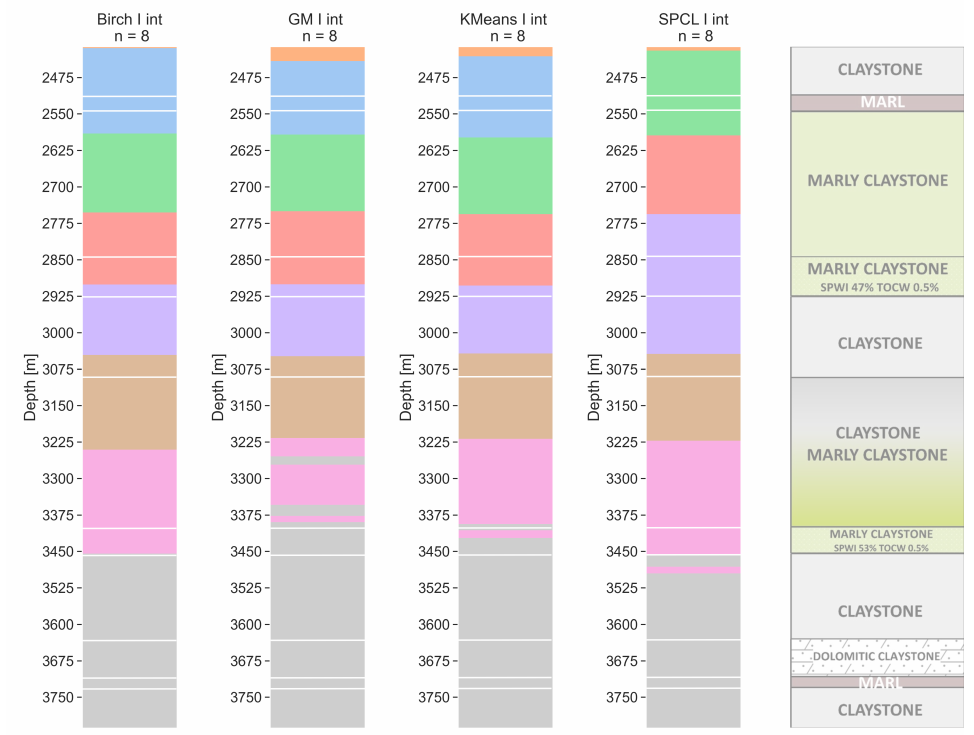
Figure 9. Sonic tool resolution clustering models for a number of clusters equal to 8 with lithology from well core (with lines). Clustering methods: BIRCH—balanced iterative reducing and clustering using hierarchies, GM—Gaussian mixture model, k-means, and SPCL—spectral